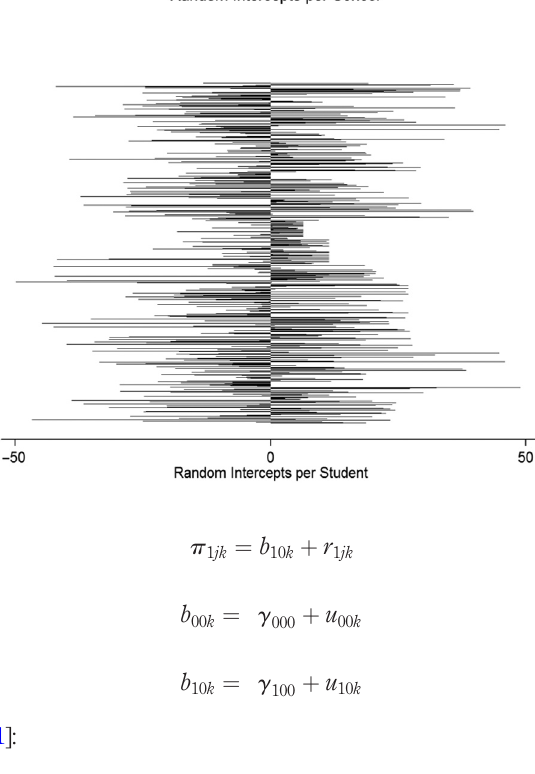
Figure 7. Random intercepts per